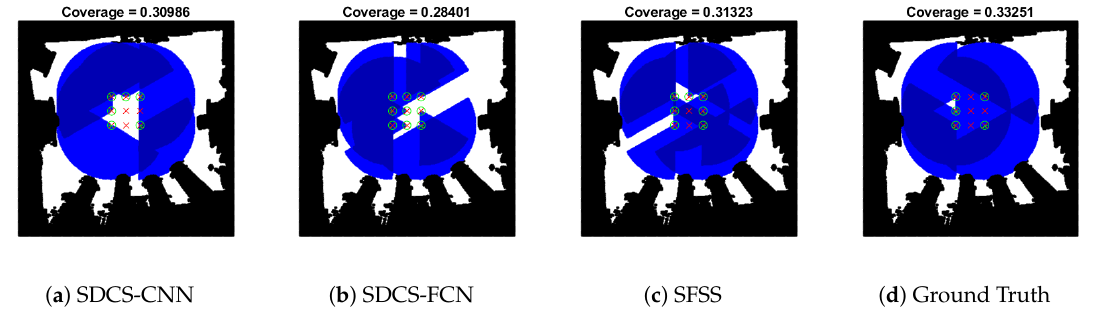
Figure 14. Coverage area is shown in Map-0 with Figure 12b.